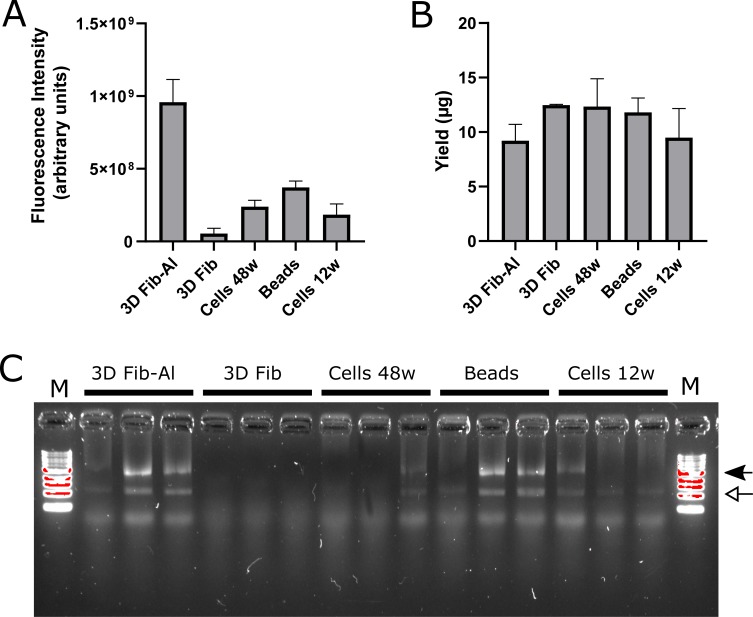
Cells cultured in 3D scaffolds and 2D monolayer culture dish.Cells cultured in fibrinogen-alginate (3D Fib-Al) and fibrinogen (3D Fib) scaffolds, on PCL-PNIPAAM (Beads) or in 48 well (Cells 48w) and 12 well (Cells 12w) culture plates (All n = 3) were stained for their viability with Alamar Blue (A). Arbitrary units are given on the y-axis. RNA concentration (B) from Trizol extraction for the same samples is given (μg) on the y-axis. Error bars represent the standard deviation. Gel electrophoresis (C) indicated separation of the 28S and 18S RNA units in most samples (locations indicated by closed or open arrow, resp.). Sample lanes are flanked by a 1kb DNA ladder (M).